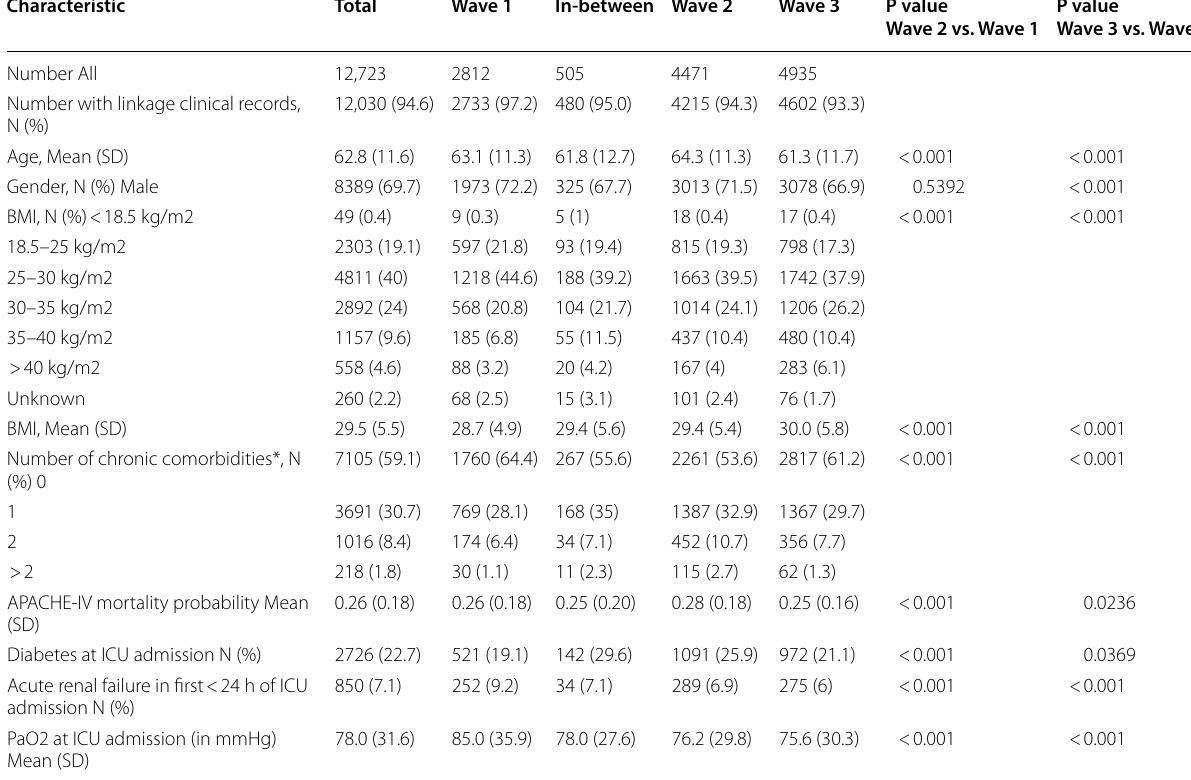
Table 1 Patient